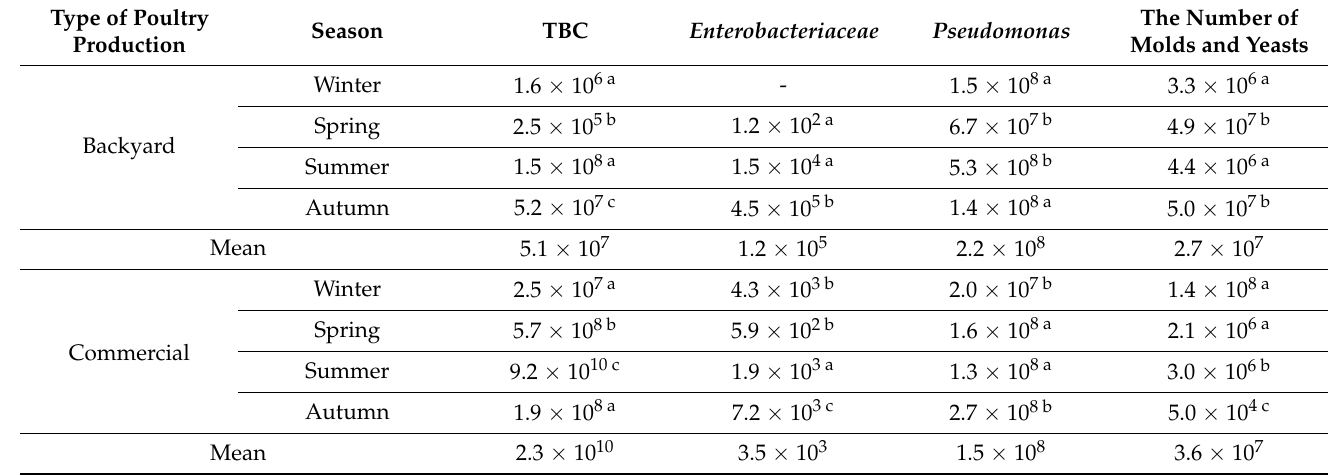
Table 2. Average microbial contamination (CFU/g) of settled dust collected from inside the